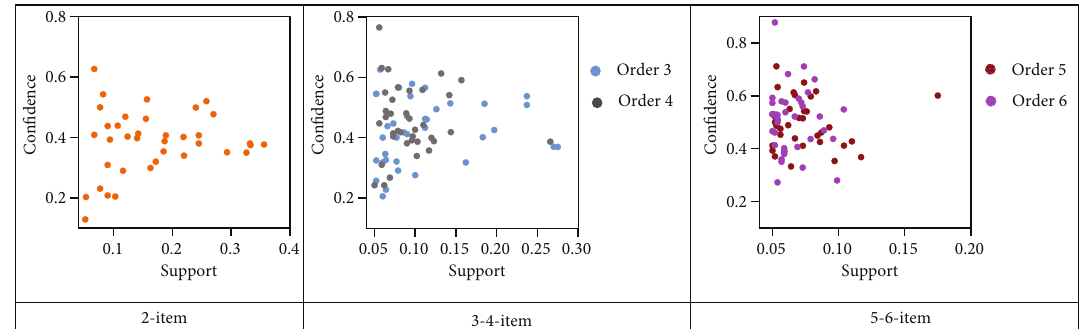
Figure 6: Two-key plots for near-crash